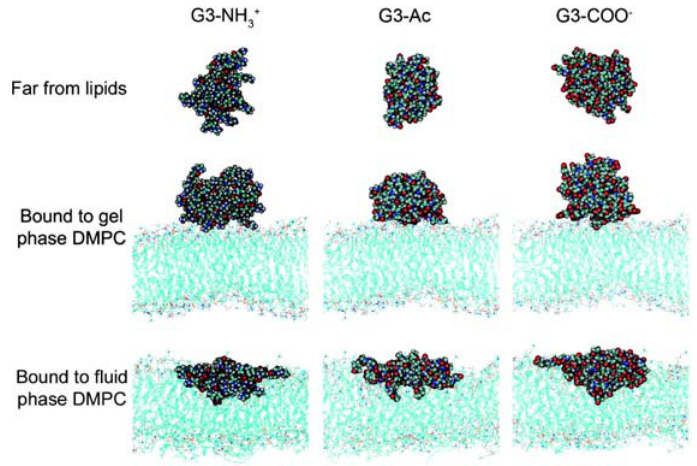
Figure 3 . Snapshots of differently charged G3 dendrimers in fluid- and gel-phase DMPC bilayers. Reprinted with permission from [27]. Copyright 2008 American Chemical